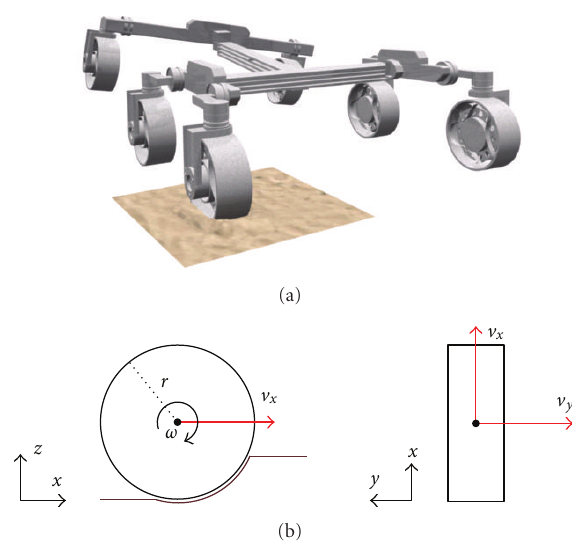
Figure 2: MBS model and contact model illustrated (a). Velocity vectors diagram in the coordinate system of a wheel